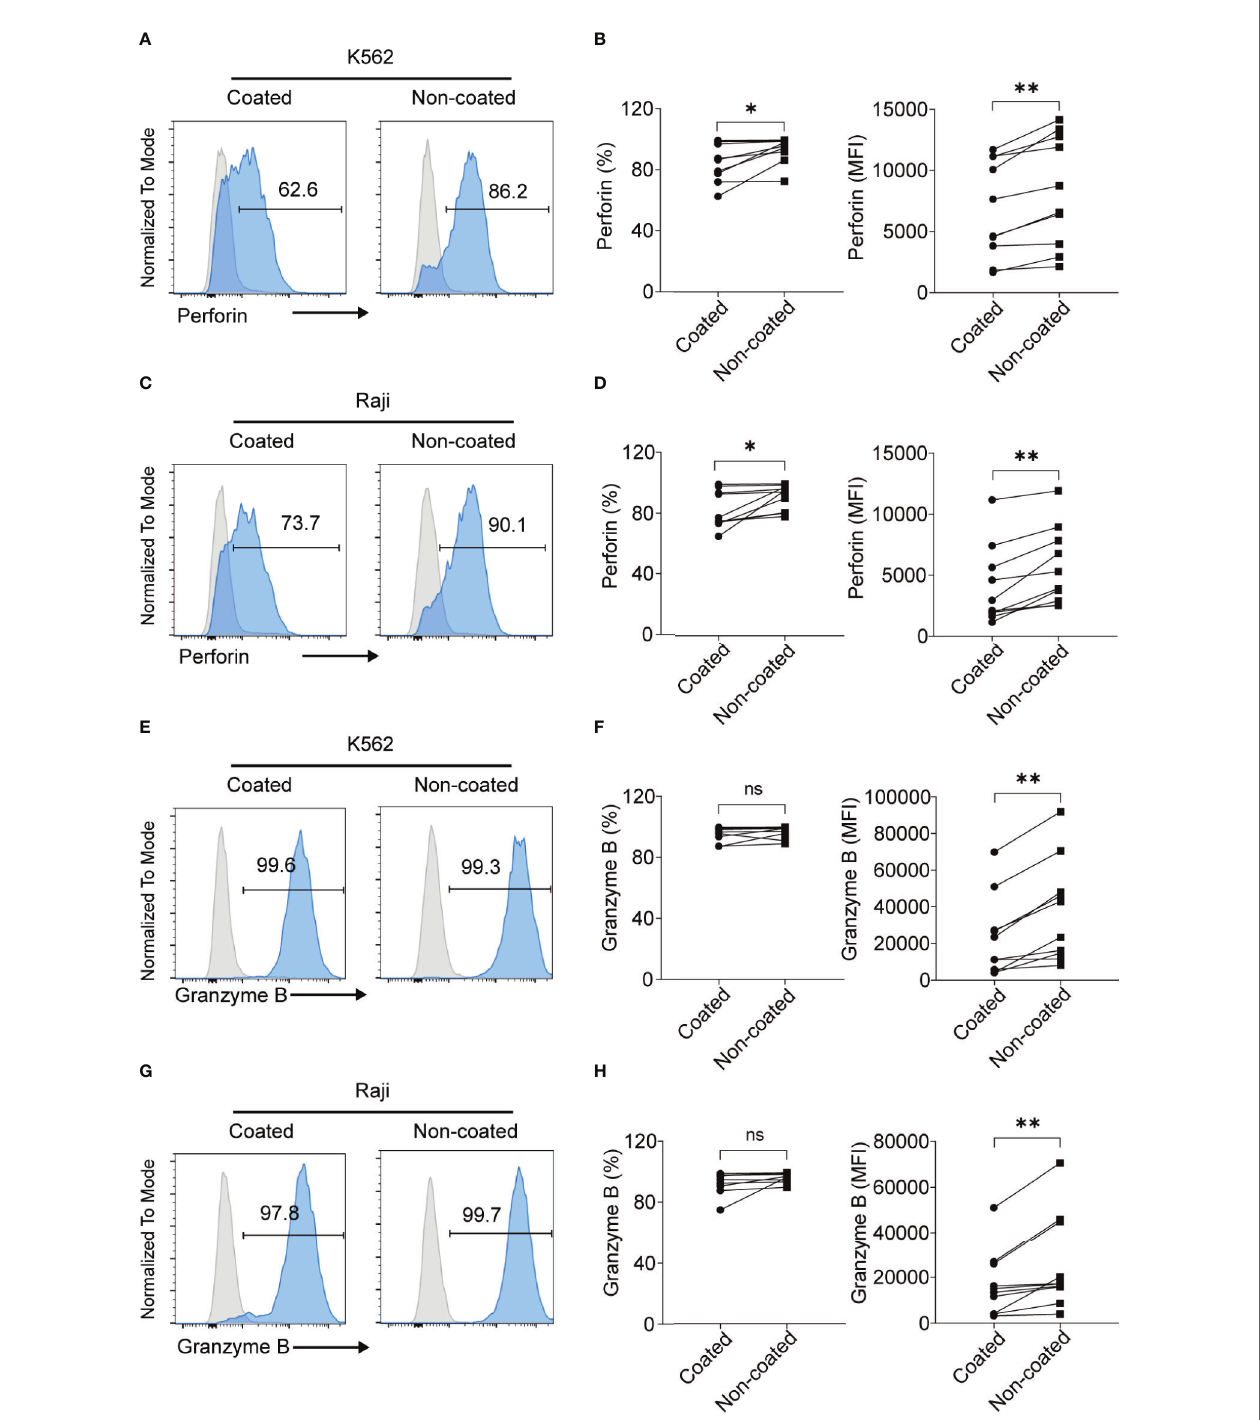
FIGURE 3 | NK cells expanded with non-coated rituximab had higher levels of perforin and granzyme B expression. NK cells were collected after expansion for 14 d. (A, C, E, G) Flow cytometry analysis of perforin + and granzyme B + NK cells induced with coated or non-coated rituximab from one representative donor. NK cells were incubated with K562 or Raji cells for 4 h, followed by perforin and granzyme B staining. (B, D, F, H) Quanti fi cation of perforin + and granzyme B + NK cells activated with coated or non-coated rituximab. n = 10 donors, ns, not signi fi cant p > 0.05, * p < 0.05, ** p < 0.01; two-tailed paired